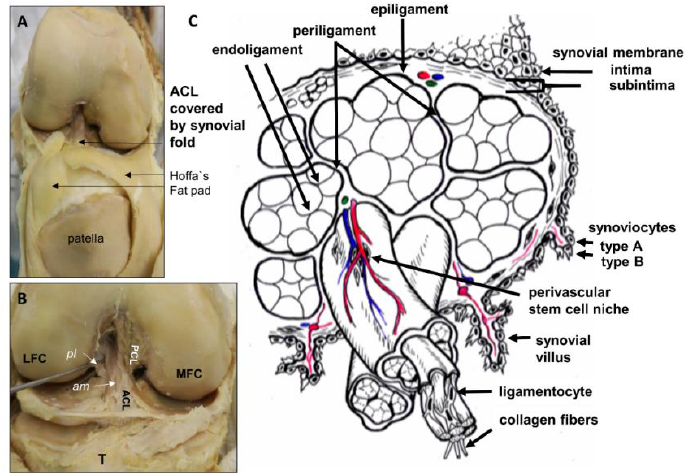
Figure 1. Human anterior cruciate ligament (ACL) gross anatomy and scheme of its histoarchitecture. ( A ): Gross anatomy of the ACL (visible within the intercondylar notch) covered by the synovial membrane and neighbored to the Hoffa ’ s fat pad. A frontal view of the knee joint with opened joint capsule is shown. ( B ): The synovial membrane has been removed and the anteromedial (am) and posterolateral (pl) bundles of the ACL and the posterior cruciate ligament (PCL) attachment site became visible. ( C ): Scheme of the micoanatomical hierarchical structure of the ACL midsubstance. Fascicles are surrounded by the periligament, subfascicles by the endoligament. LFC, MFC: lateral and medial femoral condyles, T: Tibia.